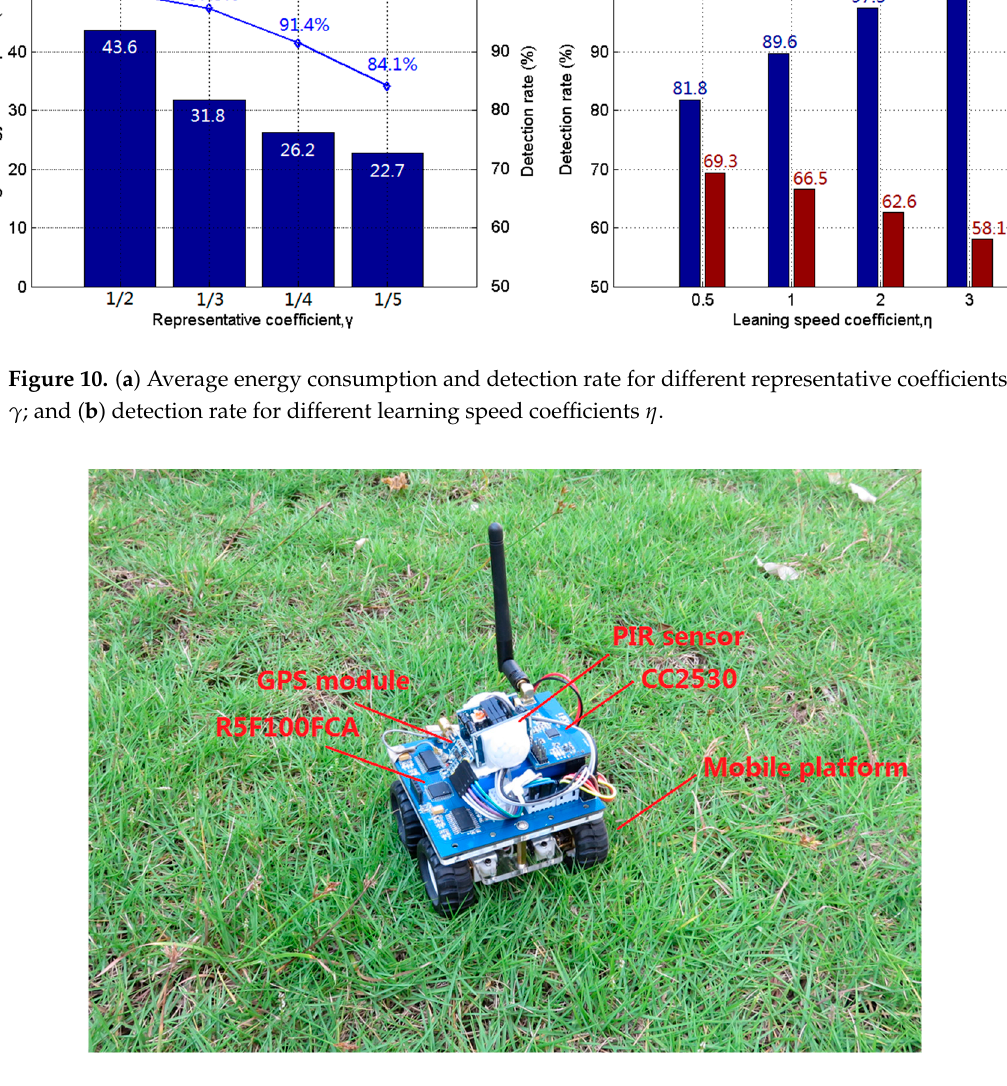
Figure 11. Illustration of the mobile sensor node for experiments.